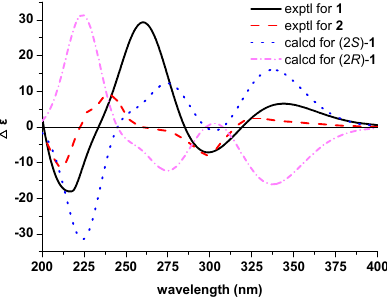
Figure 3. Experimental electronic circular dichroism (ECD) spectra for 1 and 2 ; and calculated for 1 .